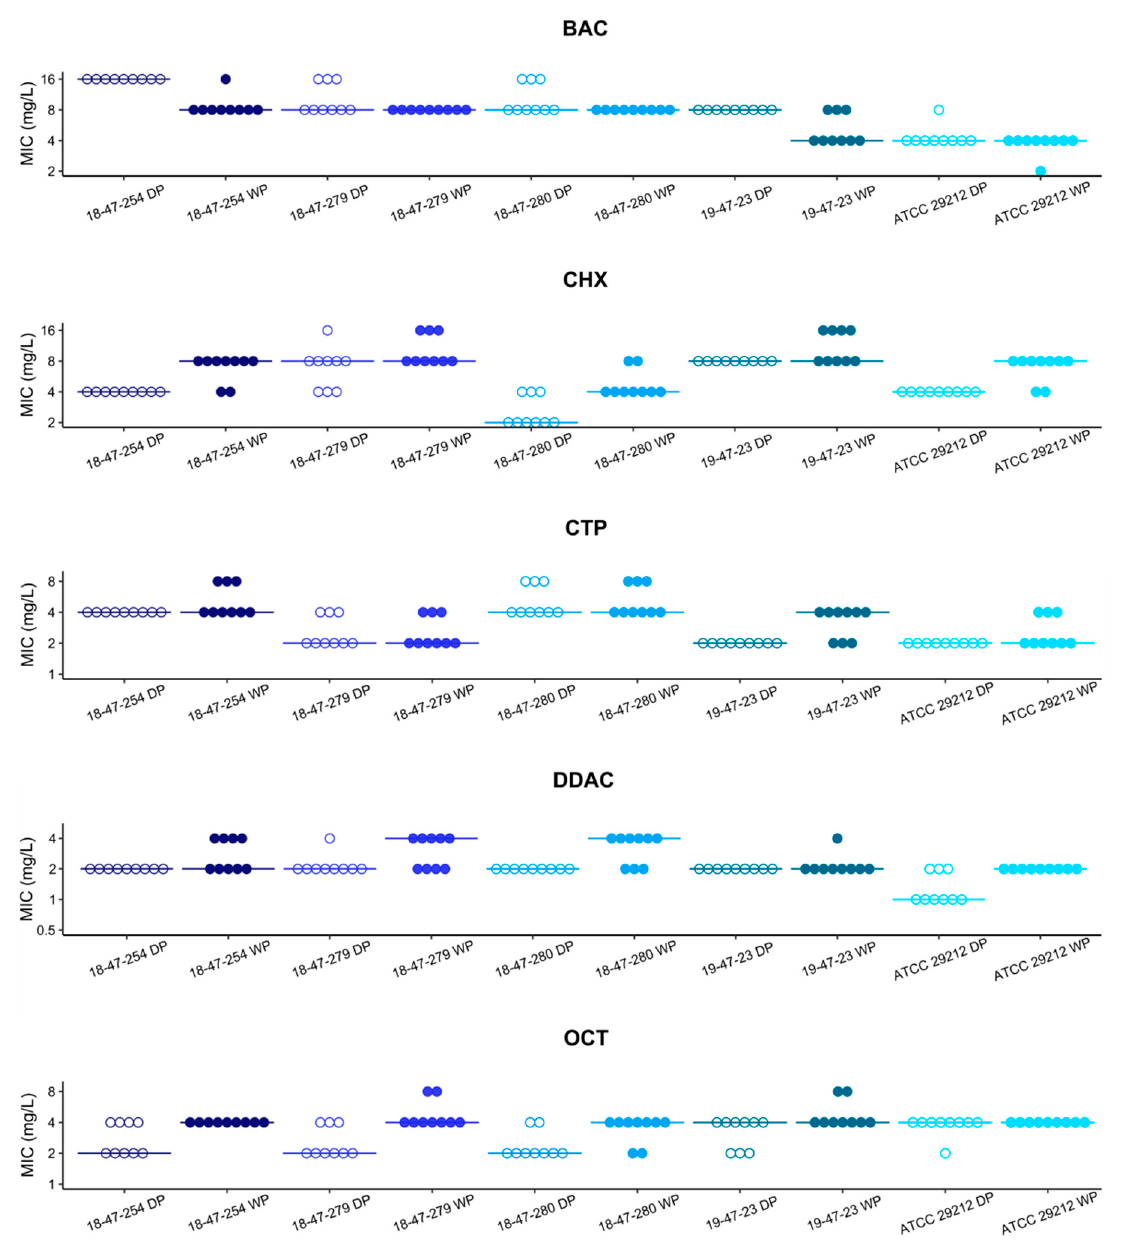
Figure 1. Susceptibility of three Enterococcus faecium (18-47-254, 18-47-279, 18-47-280) and two E. faecalis (19-47-23, ATCC 29212) strains to cationic biocides. Minimum inhibitory concentrations of benzalkonium chloride (BAC), chlorhexidine dihydrochloride (CHX), cetylpyridinium chloride (CTP), didecyldimethylammonium chloride (DDAC), and octenidine dihydrochloride (OCT) determined by wet plate procedure (WP; filled dots) and dried plates (DP; empty dots) are shown. Lines represent the respective modal values.